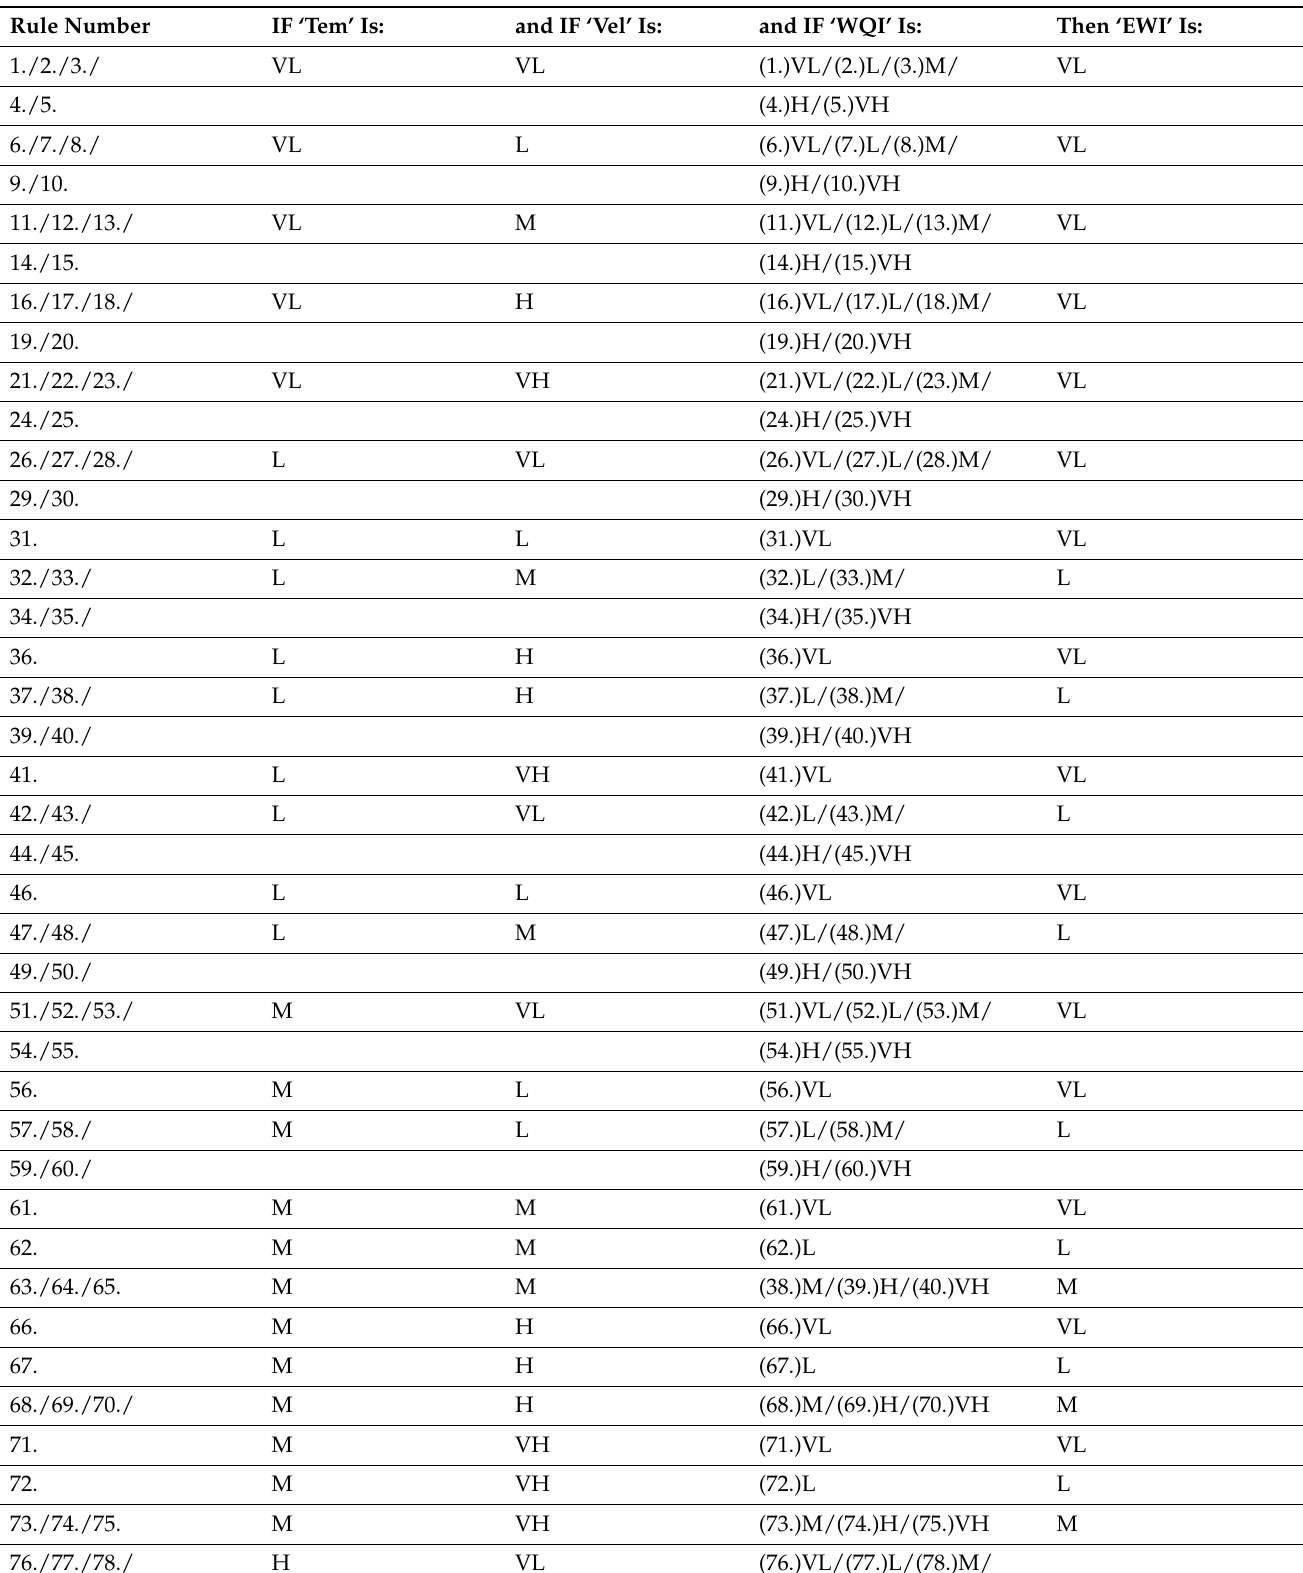
Table 3. Fuzzy rules determining the fuzzy sets of early warning